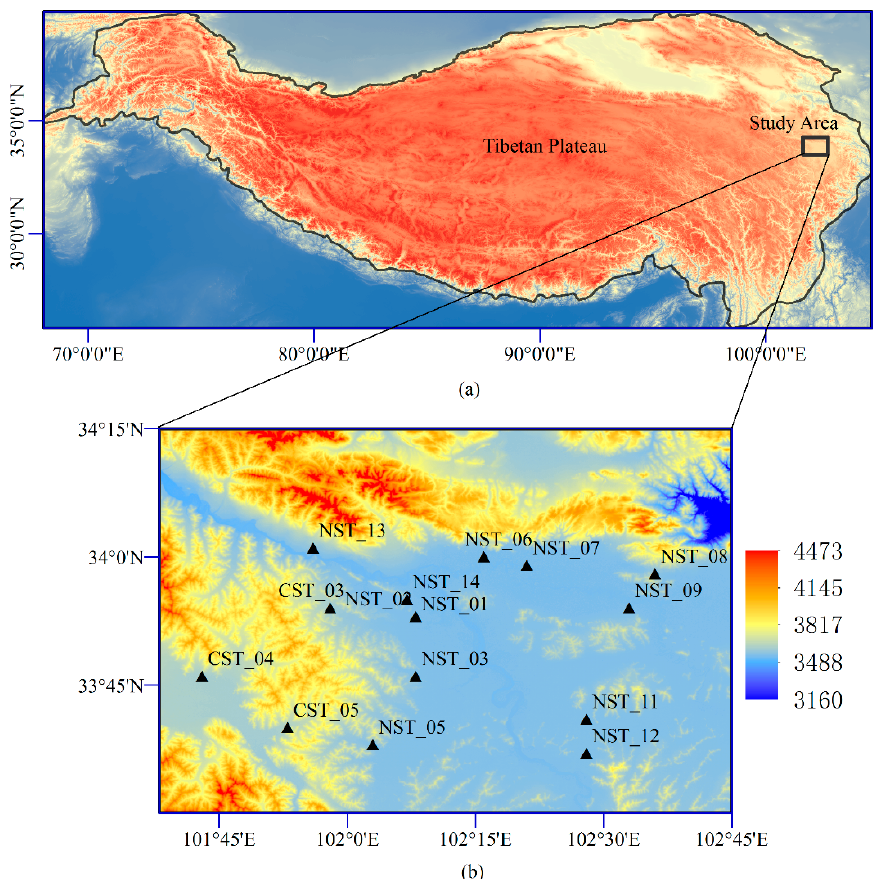
Figure 8. ( a ) Location of the study area (black rectangle); ( b ) SRTM DEM of Maqu monitoring network and location of the monitoring sites of the network.